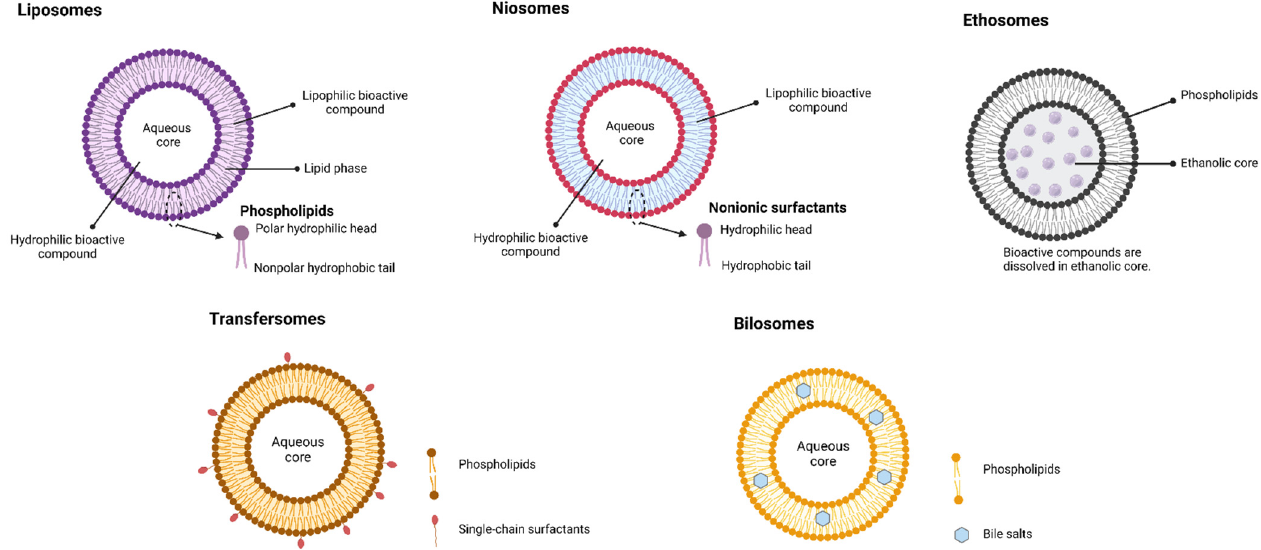
Figure 3. Classification of vesicular systems (created with Biorendor.com).